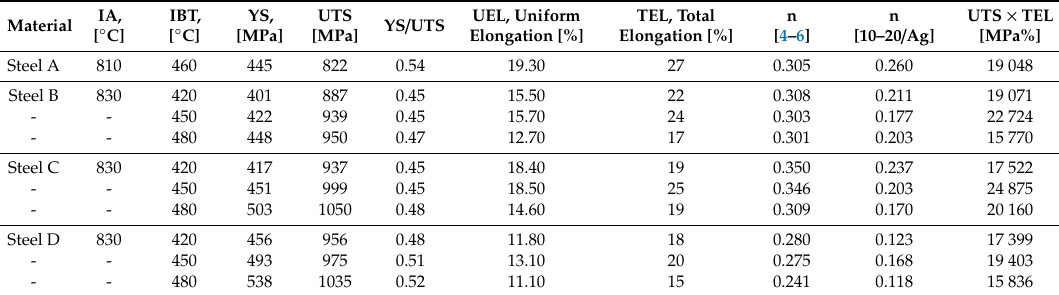
Table 5. Tensile test results of the investigated